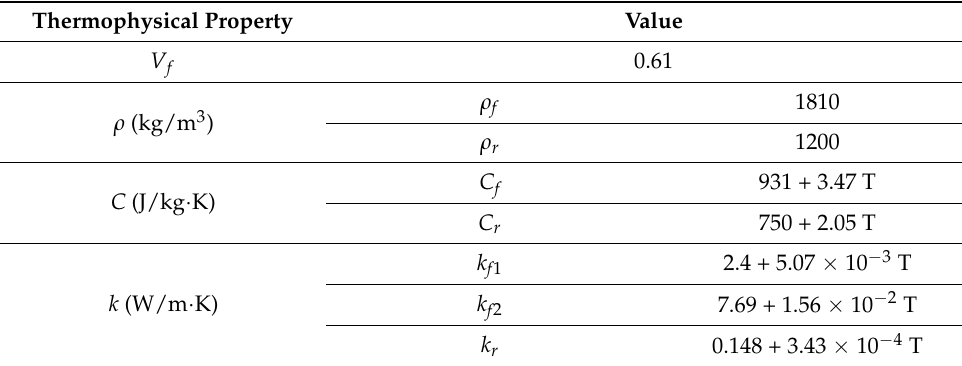
Table 1. Thermophysical properties of materials constituting